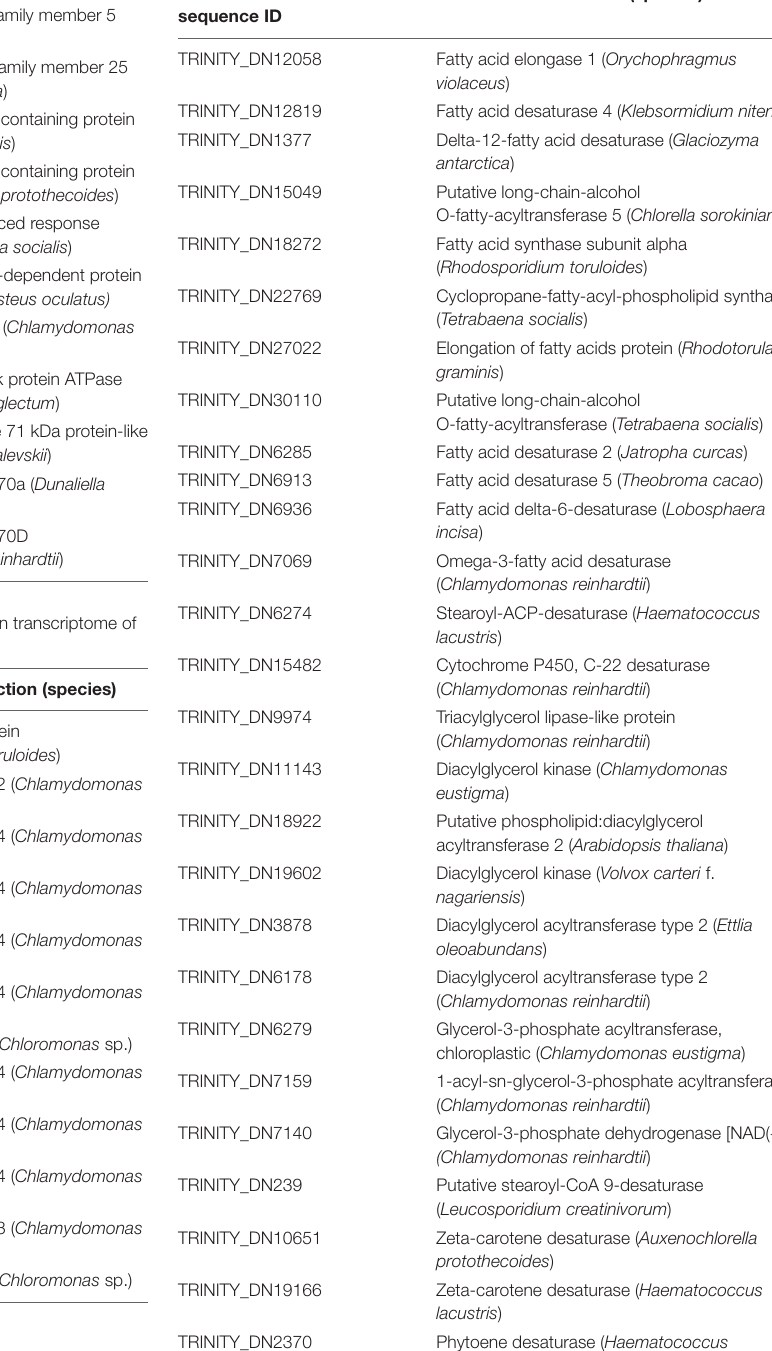
TABLE 2 | Stress-responsive genes present in the Chlorominima collina trascriptome. De novo assembled sequence ID GO molecular function (species)